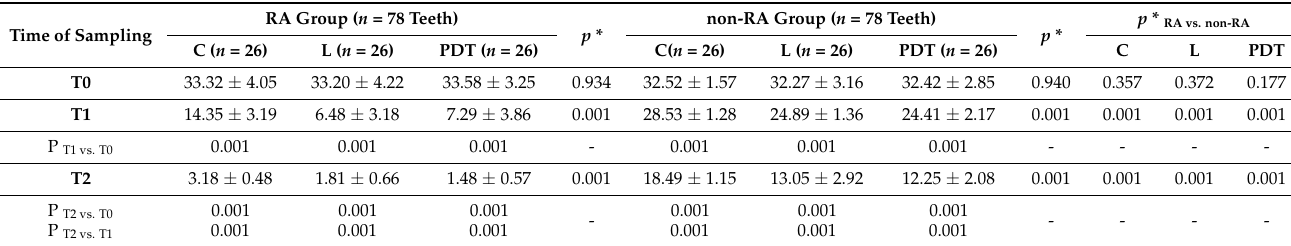
Table 4. Mean values of 4-HNE.